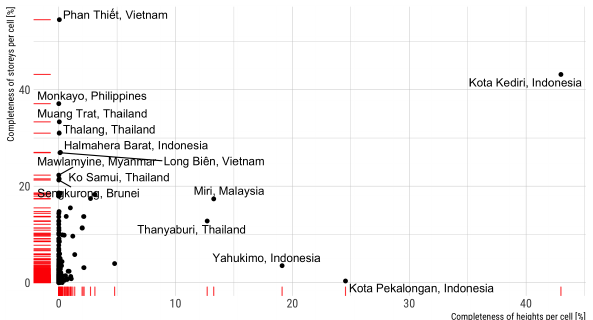
Figure 5. Understanding height/level attributes’ completeness on town level, and identifying the settlements with the highest